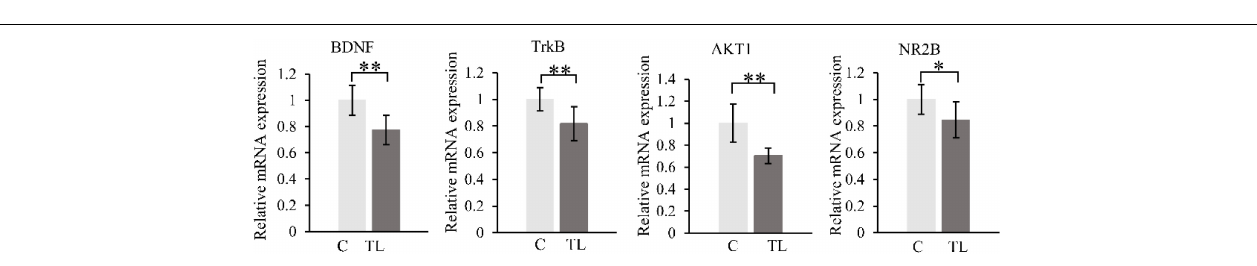
FIGURE 4 | (A) WB results about BDNF, AKT1 and PAX6 . The data are expressed as the mean ± SD, ∗ indicates that there is a statistical difference between the two groups ( t -test, ∗ P < 0.05, ∗∗ P < 0.01). (B) The activation of astrocytes in the CA1 of hippocampus. A Fluorescence detection of GFAP (green), Nuclear was labelled with DAPI (shown in blue). Quantification of fluorescence intensity of Astrocyte in two groups ( t -test, ** P < 0.01). The scale bar is 50 µ m.